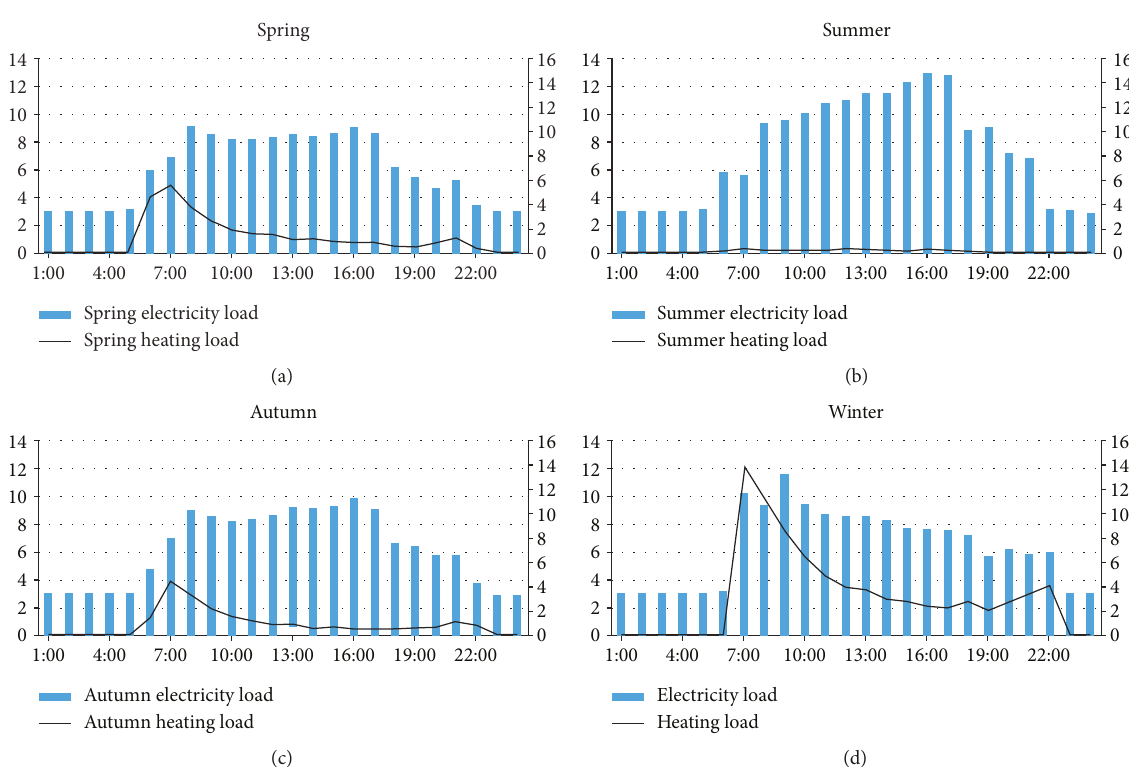
Figure 4: Daily energy consumption of the simulation building for di ff erent seasons. Table 1: Cost, energy consumption, and CO